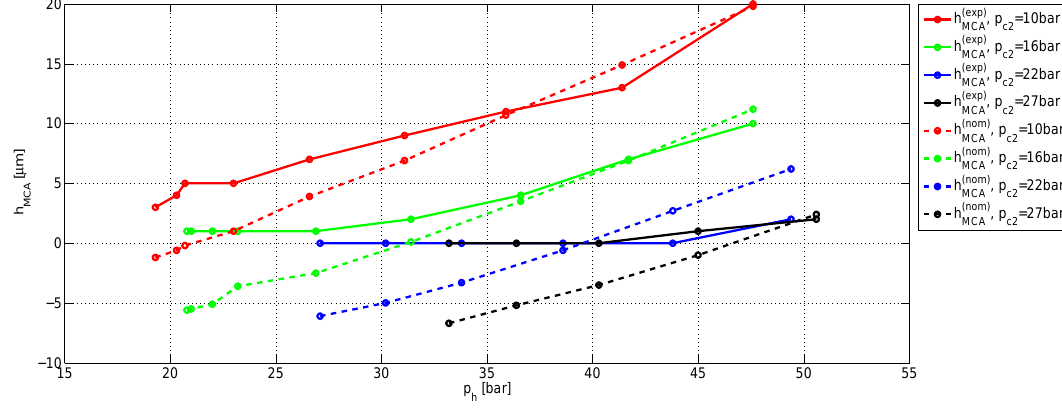
Figure 11: The simulated and experimental MCA deflections for the different p c 2 values.